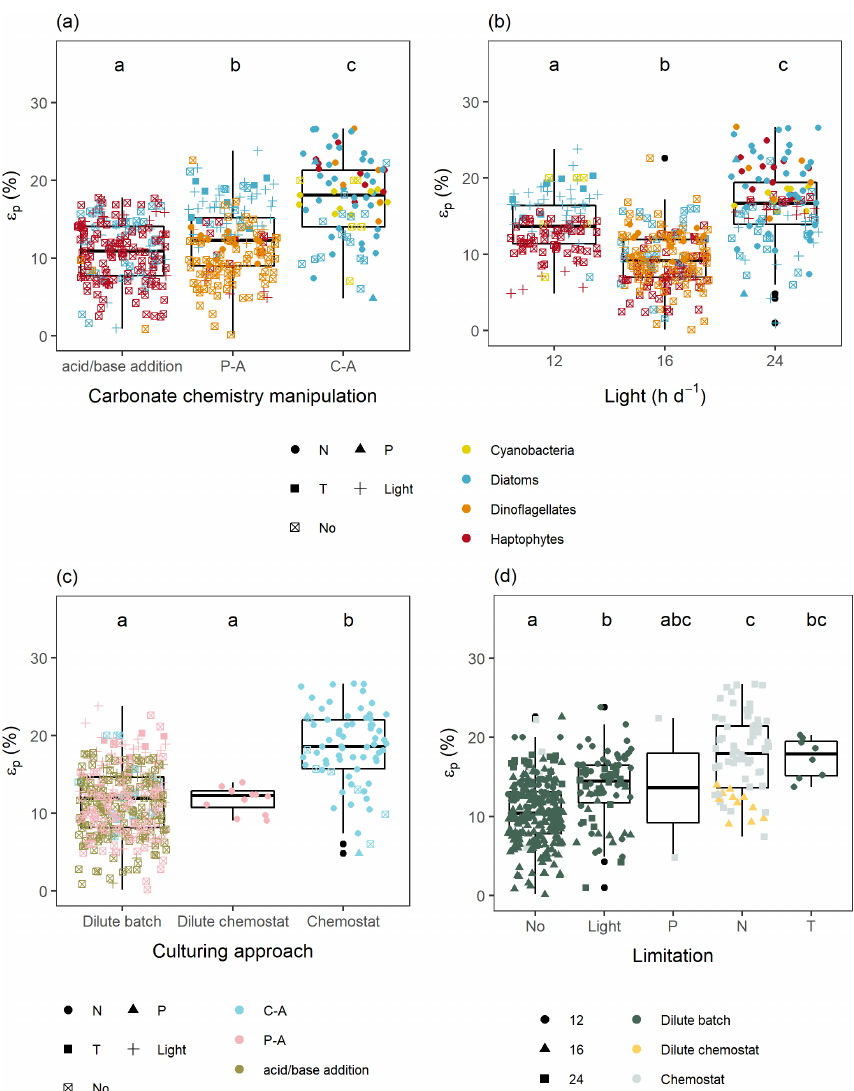
Figure 4. Differences in ε p between (a) type of carbonate chemistry manipulation (P-A is pre-aeration, and C-A is continuous aeration), (b) light-dark cycle, where colors indicate the different phytoplankton groups and shapes indicate type of limitation (N is nitrogen, P is phos- phorus, T is temperature, and No is non-limited), (c) culturing approach, where colors indicate type of carbonate chemistry manipulations and shapes type of limitation again, and (d) type of limitation, where colors indicate culturing approach and shapes light hours per day. Significant differences between experimental conditions are indicated by the letters in the respective